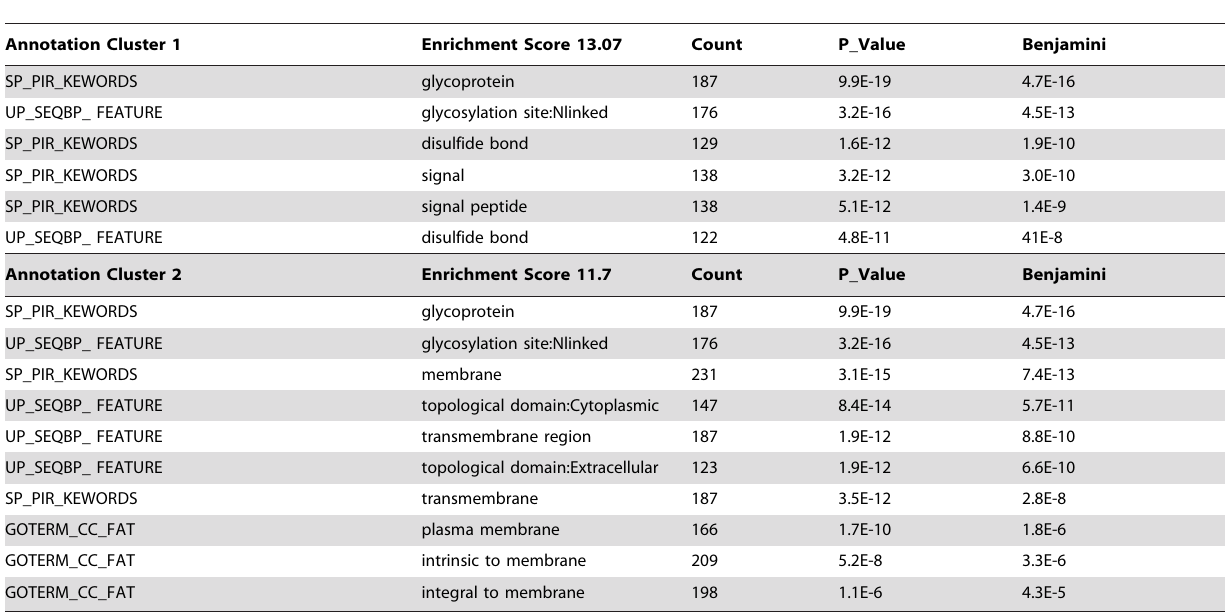
Table 2. Functional Annotation Clustering using DAVID for the top1200 unregulated genes (Log2 # 5–12) of human substantia